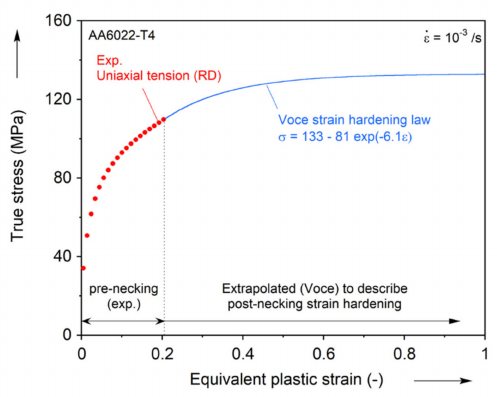
Figure 10. Extrapolation of hardening curve using the Voce hardening law.